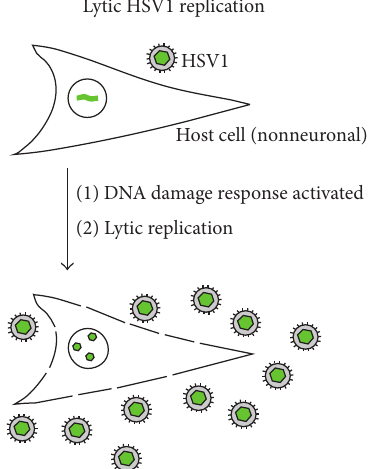
Figure 1: Illustration of lytic HSV1 replication as it is observed in nonneuronal cells. Note that host-encoded DNA damage response proteins are activated following DNA entry into nonneuronal cells and DDR proteins actively potentiate lytic virus